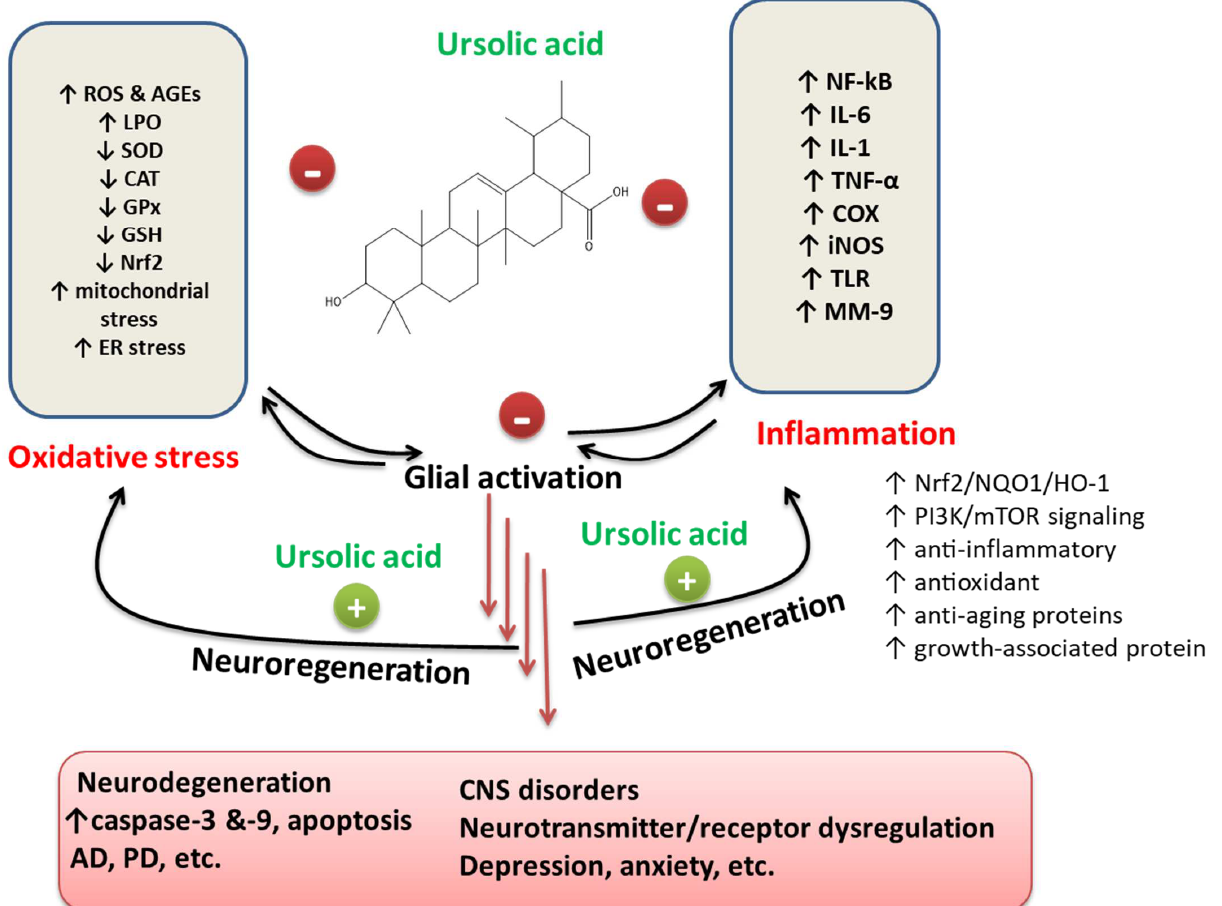
Figure 1. Anti-inflammatory and anti-oxidant mechanisms of neuronal function and neuroprotection through UA. Glial cells play a critical function in neuro-inflammation and oxidative stress, common in various neurodegenerative diseases. By repressing the making of ROS, AGEs, and LPO products and enhancing anti-oxidant defenses by upregulation of the Nrf2 signaling, UA shows neuroprotective consequences in neuronal cells (Habtemariam S, 2019). UA has various roles in the CNS. (−), inhibition; (+), promotion; ↓ , Decrease; ↑ , Increase.